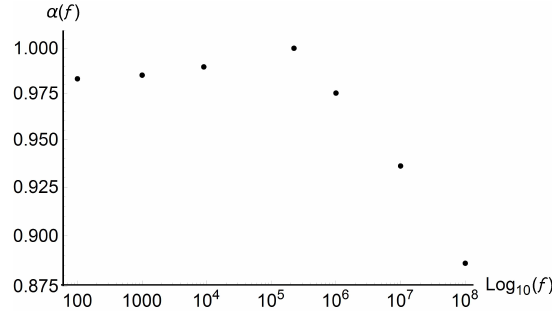
Figure 10. Trend fractional order respect to